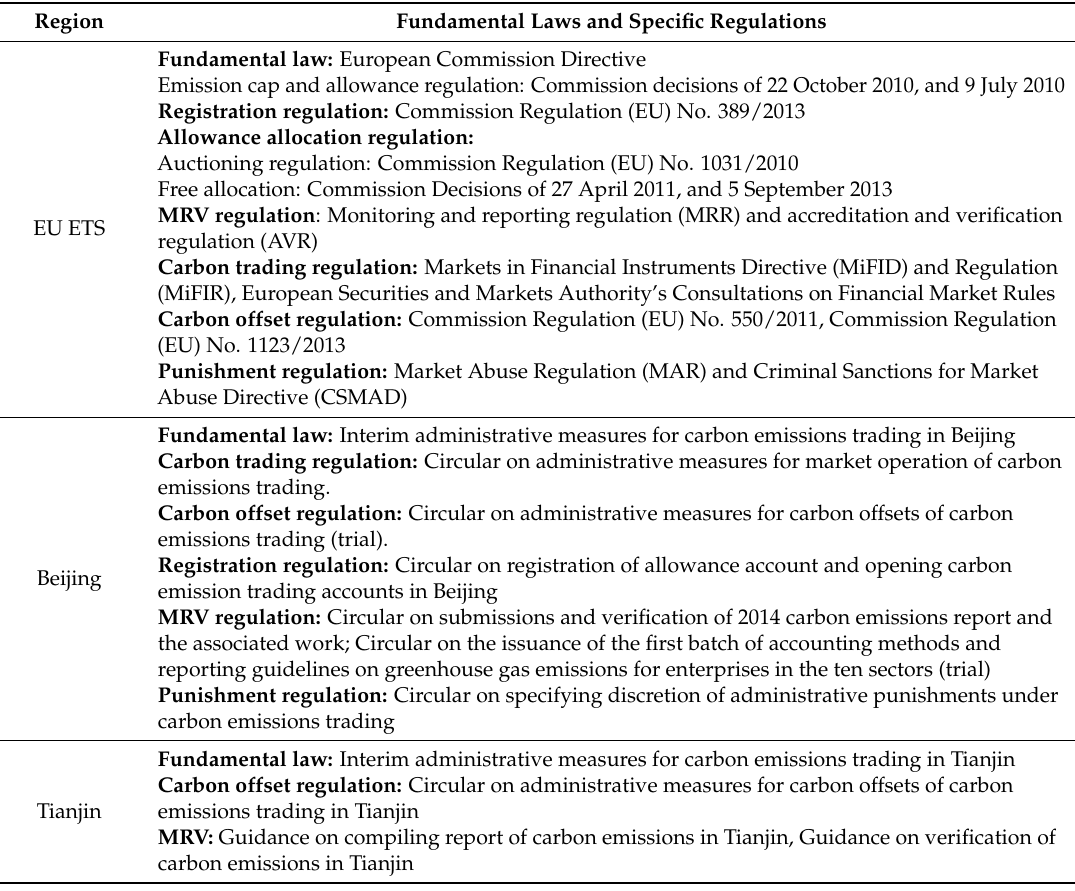
Table A1. Fundamental laws and specific regulations for EU ETS and China’s pilot